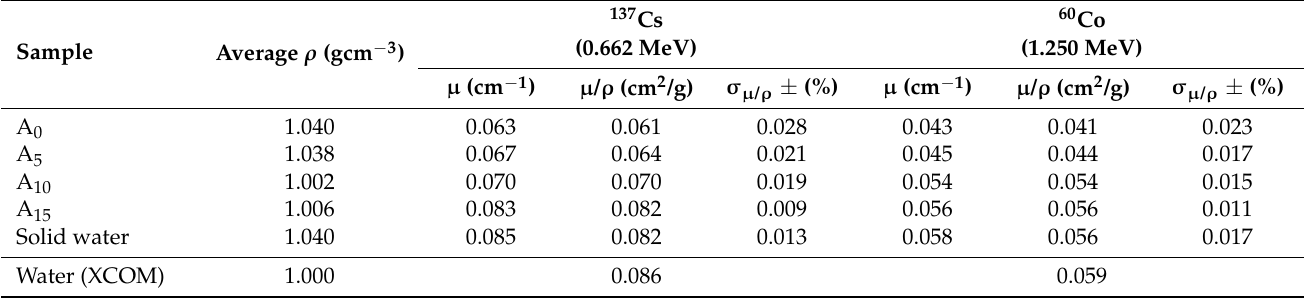
Table 4. LAC and MAC values of DSF/NaOH/IA-PAE/ R. spp. particleboards and solid water phantoms in comparison with water